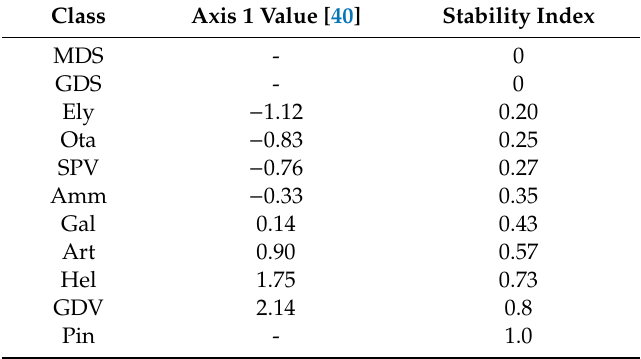
Table 2. Coordinate of each class on the first axis of the correspondence analysis and their associated stability index. Class Axis 1 Value